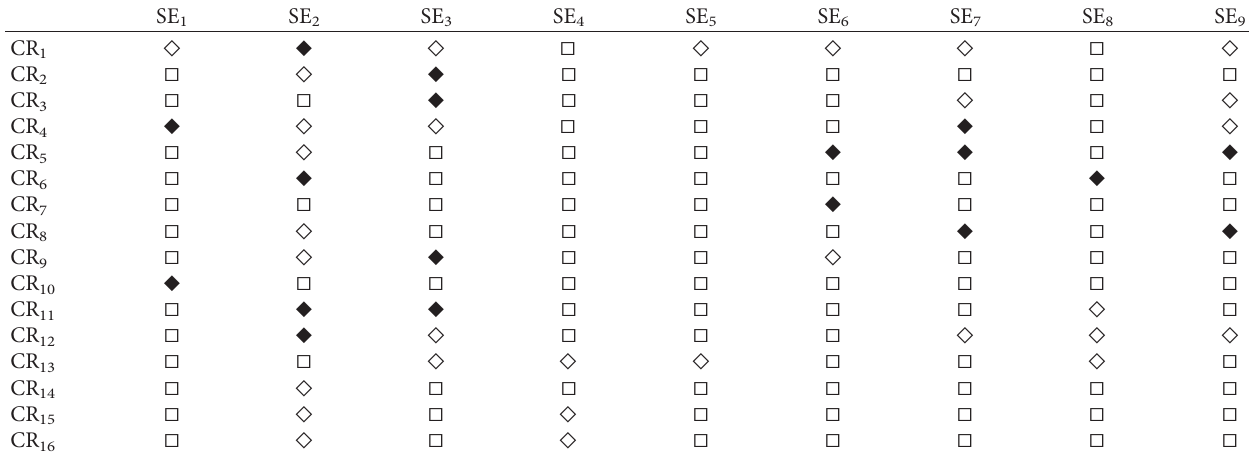
Table 6: Relationship matrix between CRs and SEs.